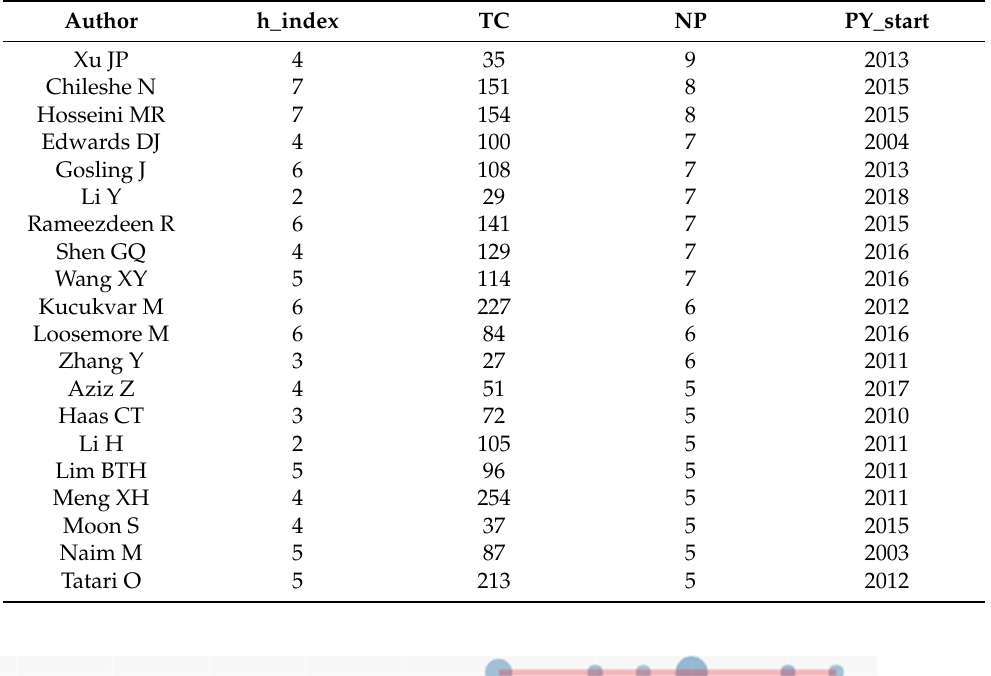
Table 3. Top 20 influential authors in the CSCM research field.